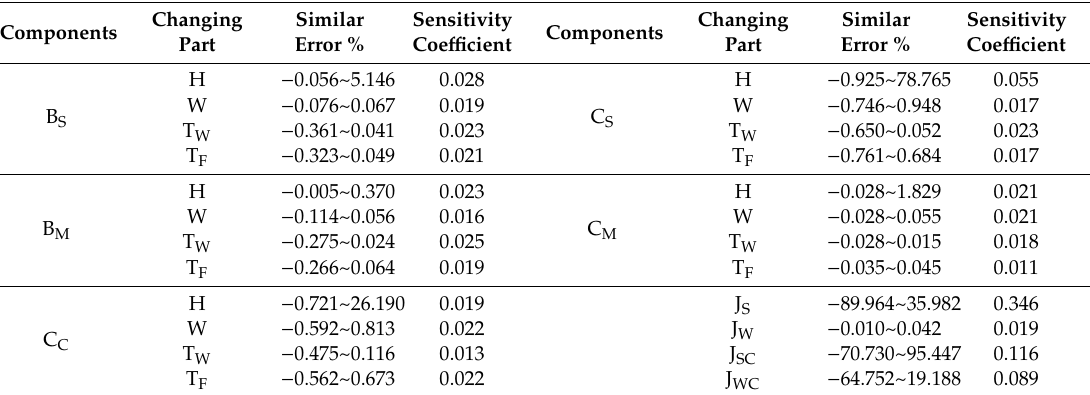
Table 6. Similar error and Sensitivity coe ffi